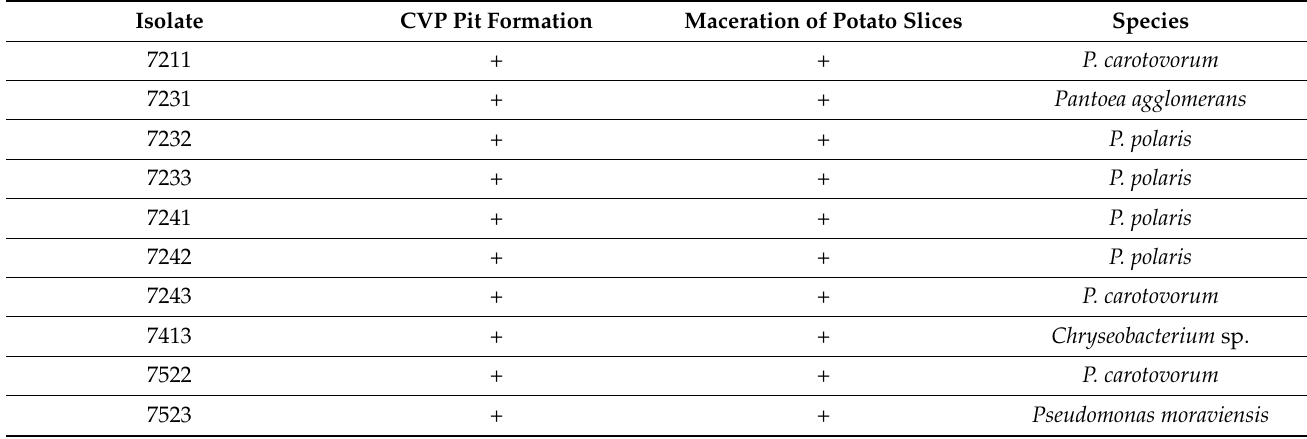
Table 3. Phage-resistant strains of pectolytic